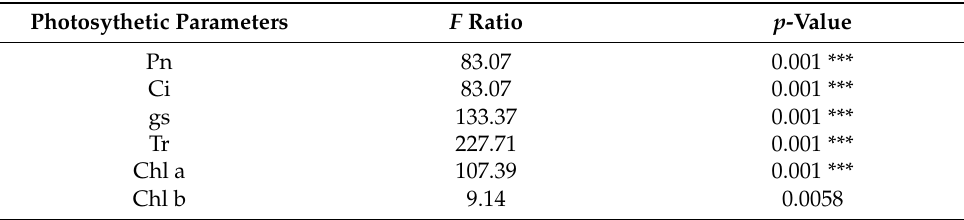
Table 1. Influence of drought stress on photosynthetic parameters in poplar 717